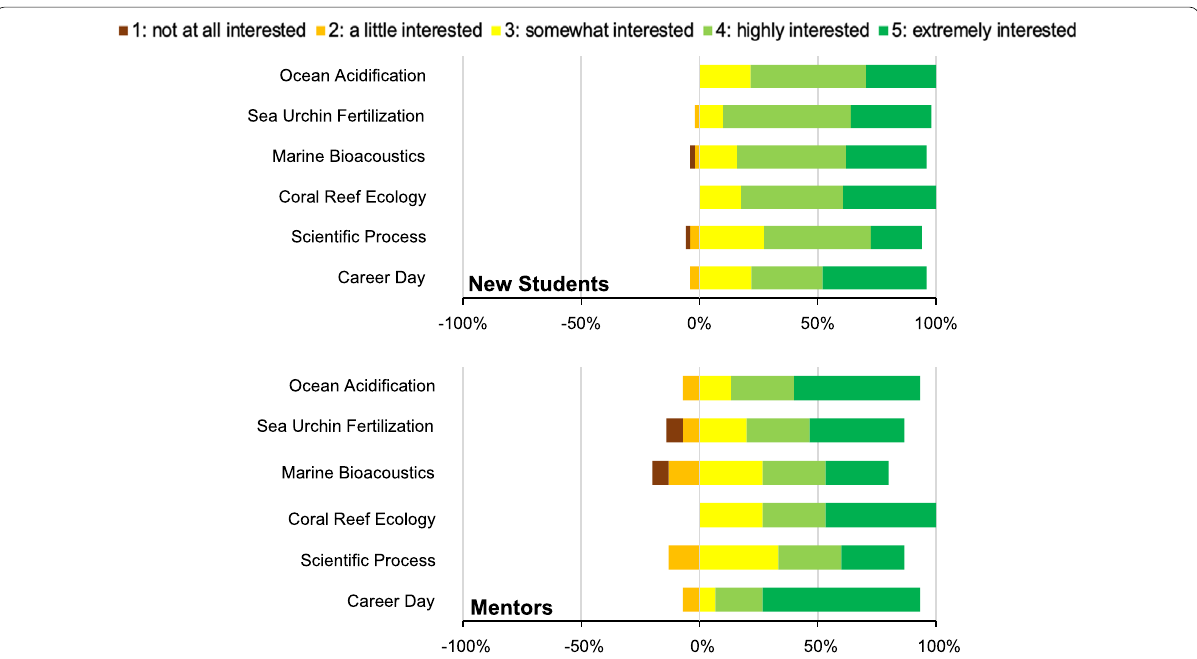
Fig. 14 Interest: Student evaluations of interest in REMS marine science modules. New Student ( N survey items (1 Not at all interested, 5 Extremely interested) relating to interest in the marine science modules delivered during 2013–2018 = = REMS programs. The survey prompt for each item is: “Please rate your interest for the [module name] lecture and lab